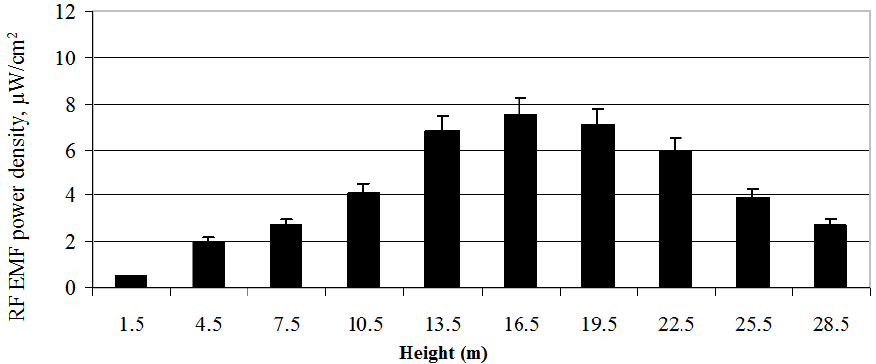
Figure 13. Distribution of the electromagnetic power density of the mobile telephony base station antenna (ERP = 1428 W) at different heights.